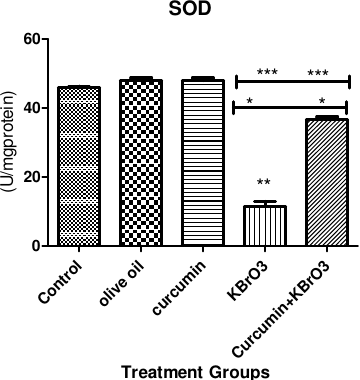
Fig. 3. Effect of curcumin on the activities of catalase in KBrO3-induced liver oxidative damage. Data are presented as the mean ± SD (n = 6). * values are significantly (p<0.05) different from control, **values are significantly (p<0.05) different from curcumin+ KBrO3, ***values are significantly (p<0.05) different from curcumin. For details, see legend in